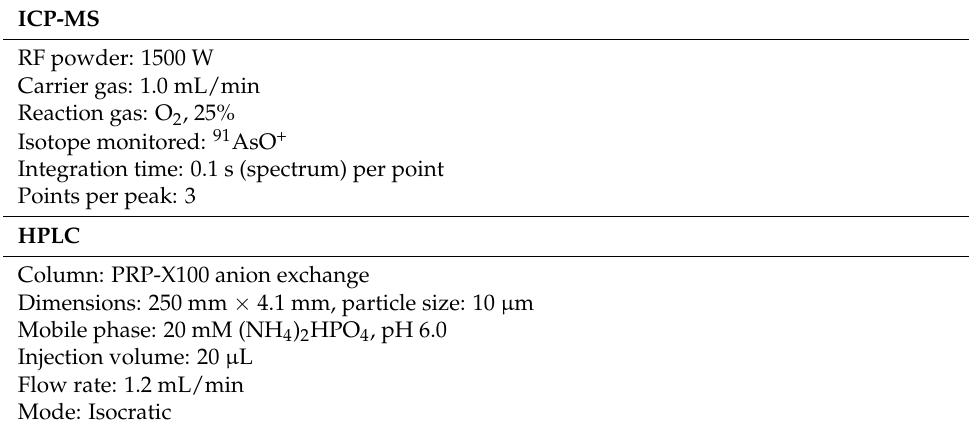
Table 1. Operating conditions of the HPLC-ICP-MS